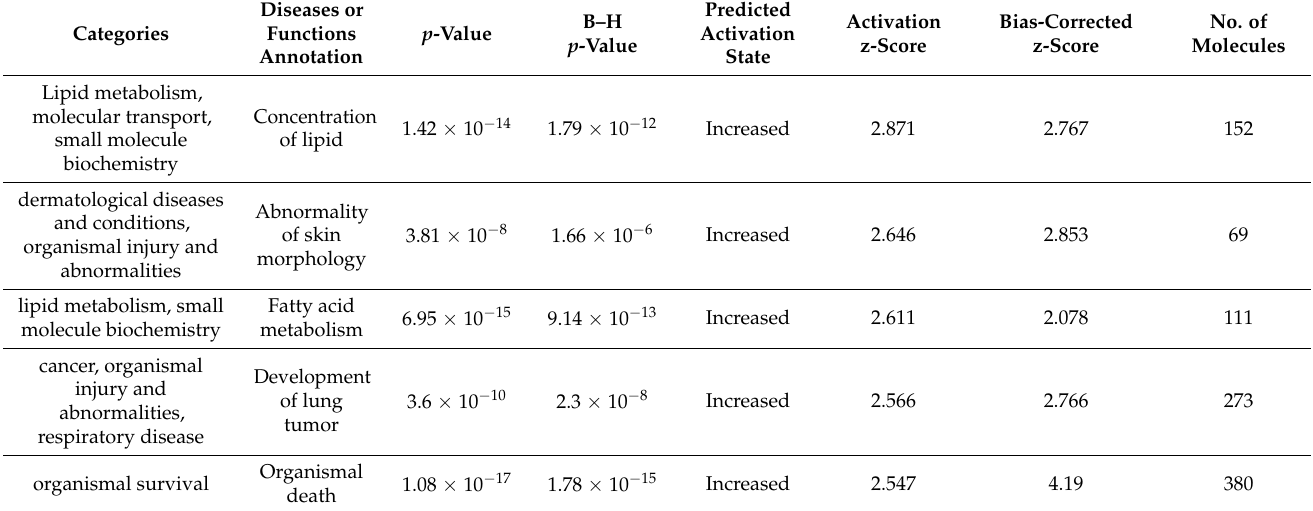
Table 3. Top disease and biologic functions analyzed with IPA (positive z -score value). Disease and biologic functions of DEGs (|fold changes| > 1.5, p -value < 0.01) in PM 2.5 -treated SZ95 sebocytes were analyzed with IPA. Z-score indicates the predicted activation (positive value) or inhibition (negative value) of the disease or function. Bias-corrected z-score is a statistically corrected value to avoid false predictions. No. of molecules is the number of genes in DEGs associated with each function. p -values were calculated by right-tailed Fisher’s exact tests and Benjamini–Hochberg correction (B–H p